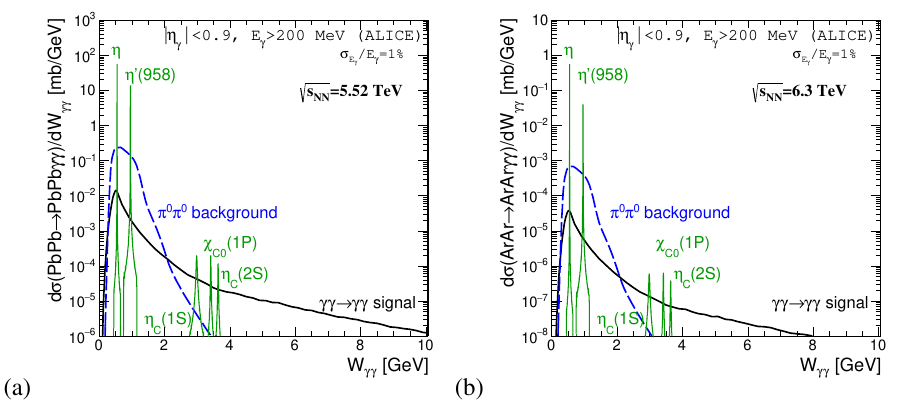
Figure 8. Di ff erential cross section as a function of W γγ = M γγ for (a) PbPb → PbPb γγ and (b) ArAr → ArAr γγ . The collision energy at the center-of-mass of the heavy ion collision is 5 . 52 TeV and 6 . 3 TeV for lead-lead and argon-argon